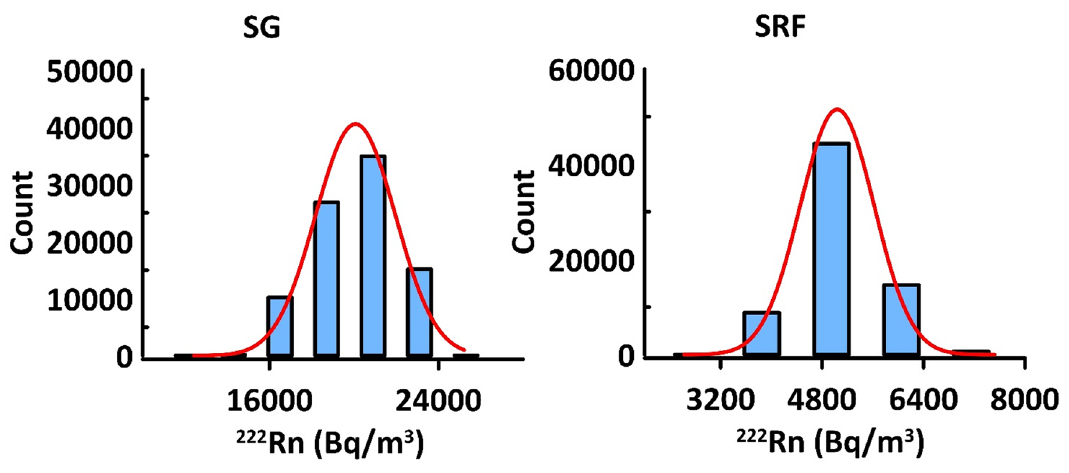
Gaussian distribution, represented as the symmetric “bell curve” shape with a red